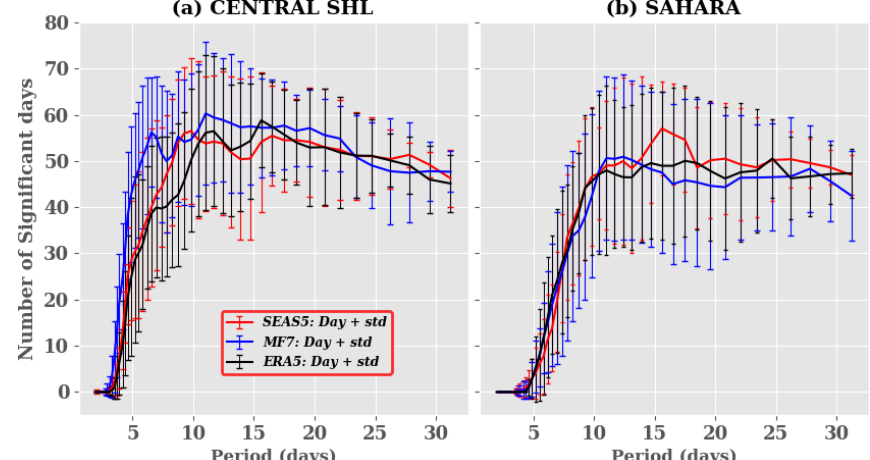
Figure 3. Climatology of significant days: significant days here refer to days with a spectral power signal greater than 1. Red, blue and black curves and bars represent the number of days and spread for SEAS5, MF7 and ERA5 respectively over the (a) central SHL box and (b) Sahara during the period 1993–2016. The computation was made just using the unperturbed member of the ensemble forecast models launched from 1 June for the JJAS period. The y axis represents significant days and x axis the duration of propagation in days.